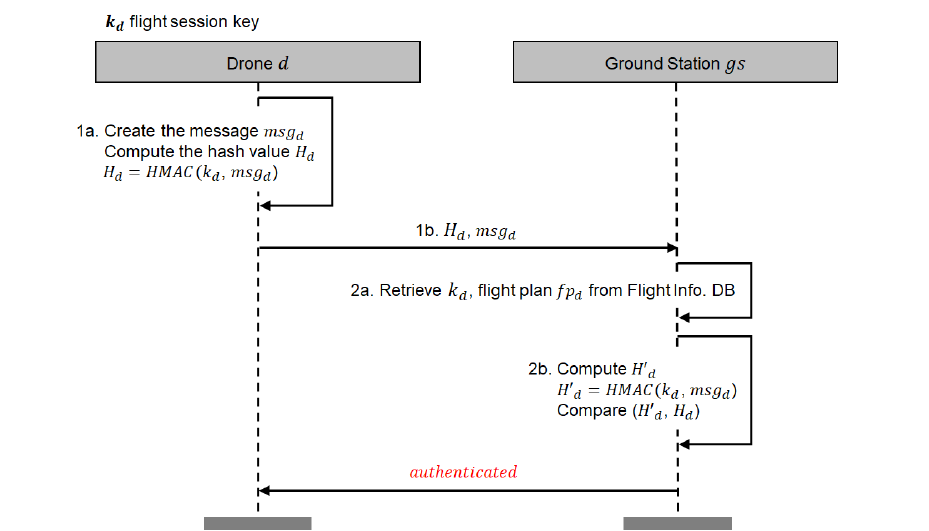
Figure 4. Authentication procedure between drone and ground station.